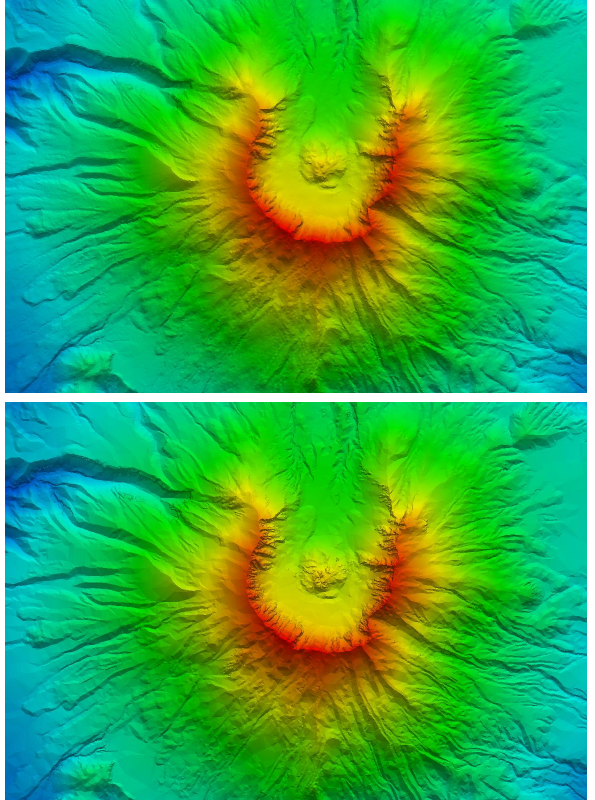
Figure 13. Grid quality from an intuitive comparison. Top: cCVT- generalised grid with nearly uniform triangles. Bottom: HFPR- generalised grid with irregular